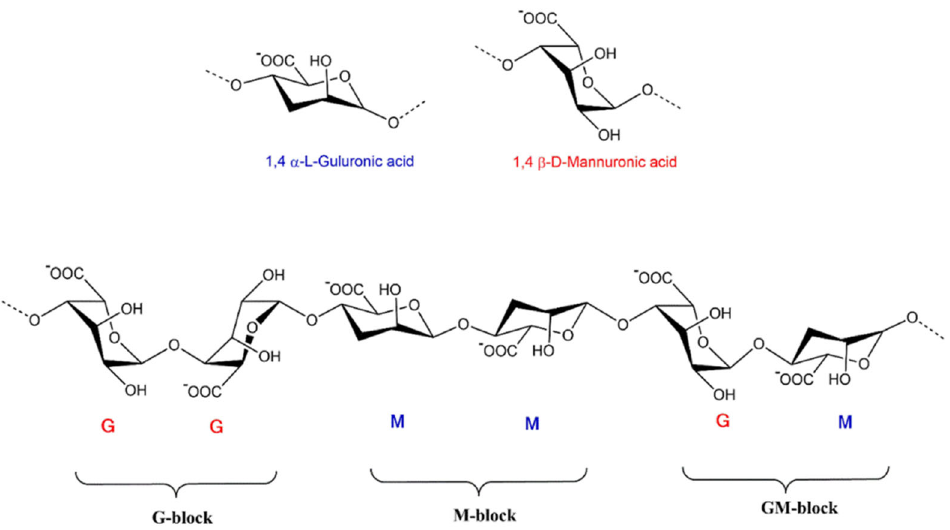
Figure 2. The monomer’s conformation and blocks distribution of ALG salt [27].